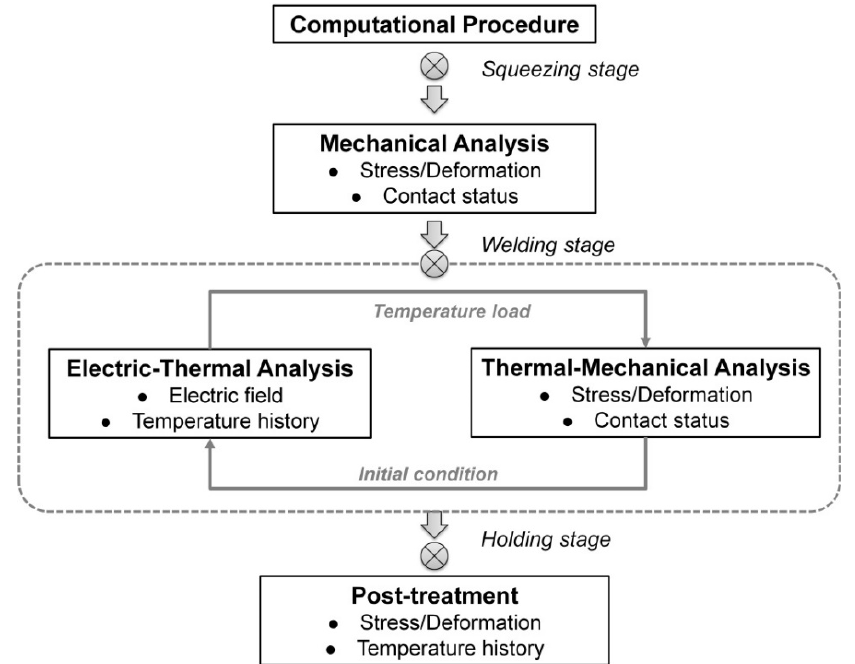
Figure 2. Schematic plot of FEM computational procedure.